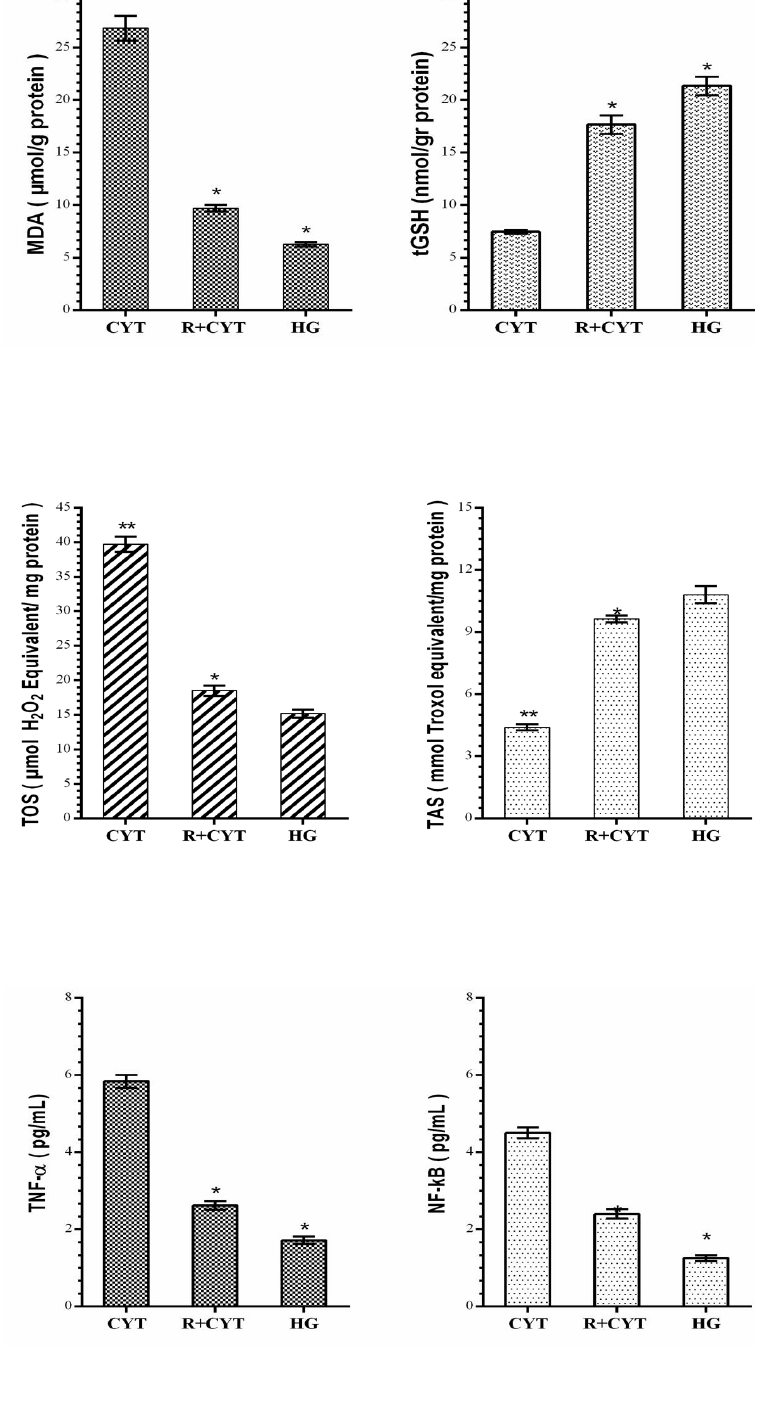
Figure 3. Malondialdehyde (MDA) and total glutathione (tGSH) levels in the lung tissues of the rats in the control (HG), cytarabine (CYT) and rutin+cytarabine (R+CYT) groups. *p<0.0001 according to control (HG) group, **p<0.0001 according to cytarabine (CYT).